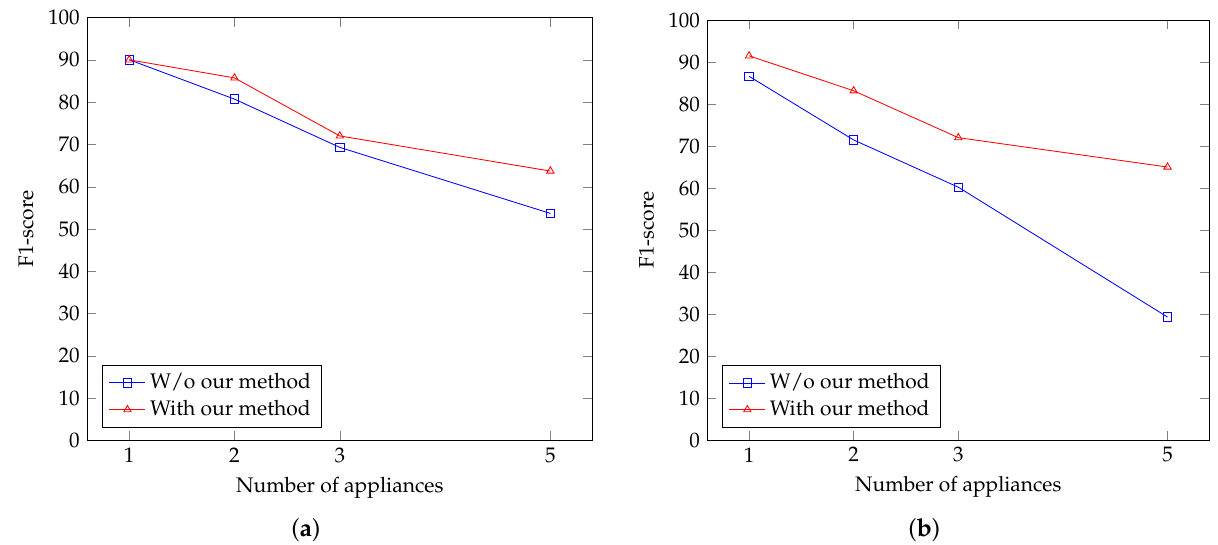
Figure 8. The F1-score corresponding to the number of appliances on UK-DALE with the ( a ) VDOCNN model and ( b ) Xception model, respectively.